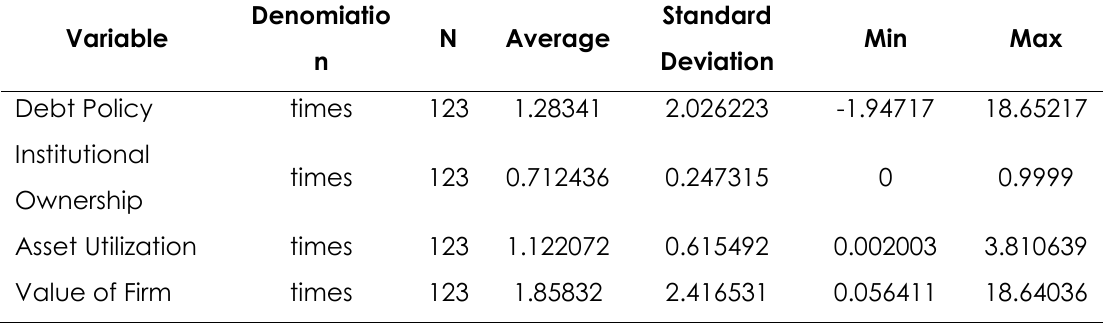
Table 2. Statistical Description among